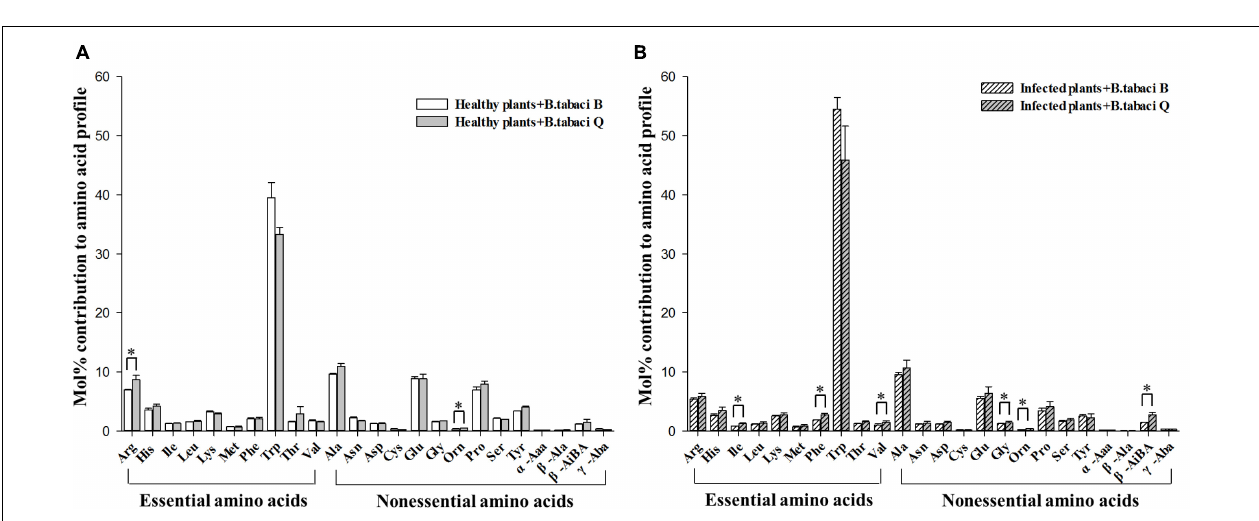
FIGURE 2 | The mol% of free amino acids in B. tabaci B and Q adults that fed on (A) healthy tomato plants or on (B) TYLCV-infected tomato plants. Values are means ( ± SE) of three replicates. ∗ Indicates a significant difference between B and Q at P < 0.05; LSD test. For abbreviations, see Table 1 .